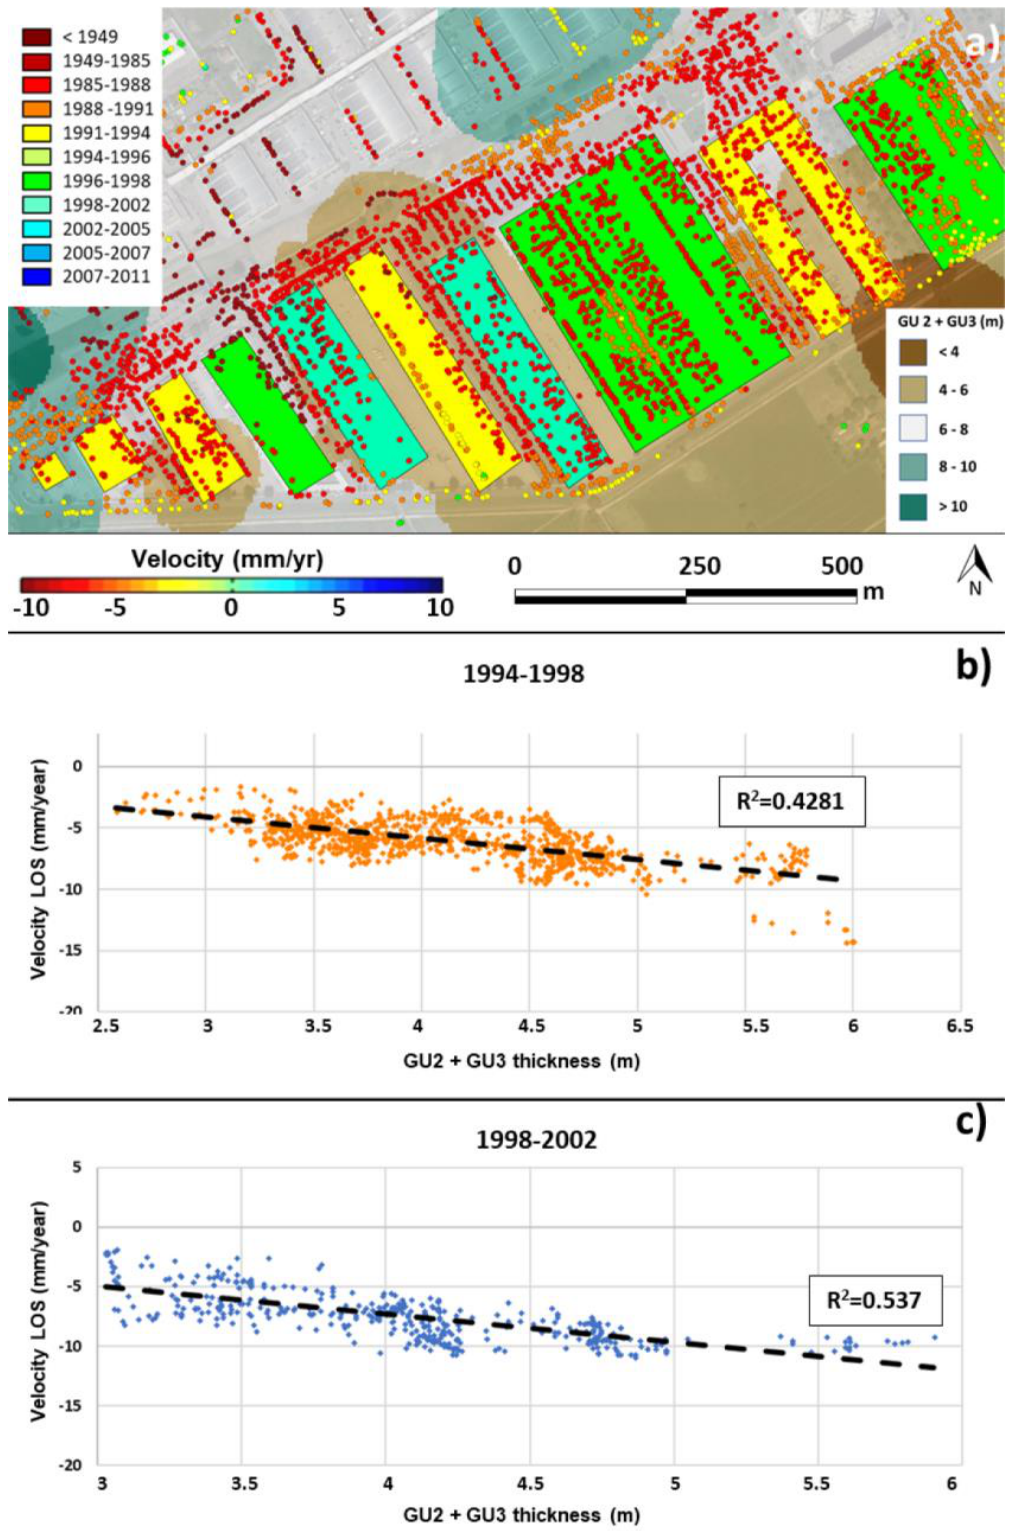
Figure 14. ( a ) Velocity of persistent scatterers of COSMO-SkyMed over a thickness map of compressible soils; the classified polygons refer to the date of construction; ( b , c ) Correlation diagrams between the PS velocity and the soft-soil thickness in the region for structures built between 1994–1998 and 1998–2002, respectively.